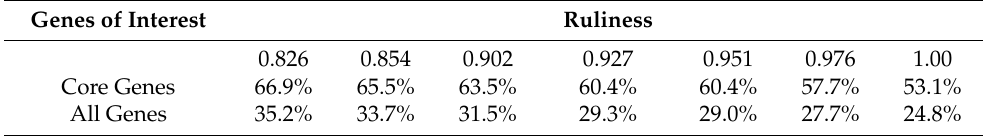
Table 1. Percentage of chlorovirus genes in gene gangs. Percentage of chlorovirus genes contained in gene gangs as a function of ruliness. Core genes were much more likely to exist in gene gangs than genes at large, which may reflect that the same evolutionary forces working to conserve genes may also act to spatially constrain